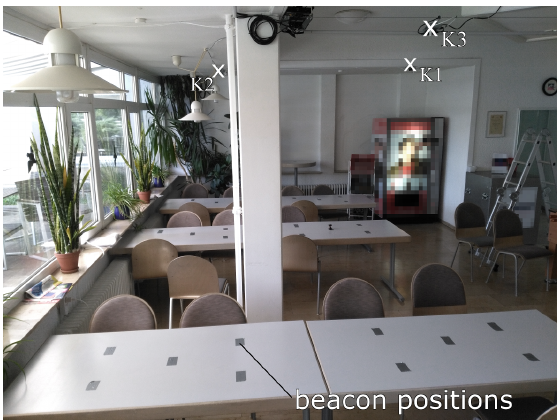
Figure 19. Experimental scenario for the machine learning experiments. A beacon is put on a table approximately at the marked cluster positions and the aim is to correctly estimate the cluster it is in by training each machine learning algorithm with the TDoA measurements of multiple positions on